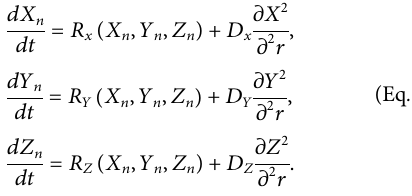
molecules ( X n ≥ 0, Y n ≥ 0, and Z n ≥ 0). These molecules react according to the molecular network in each cell (Eq. 9 and Figure 7C) and diffuse between neighboring cells. The